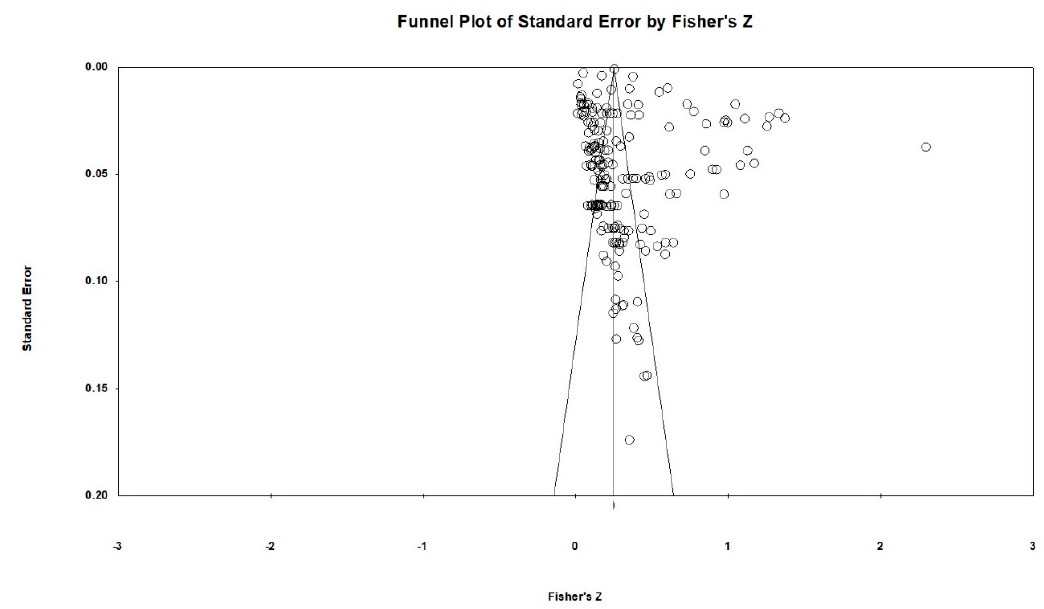
Figure 3. Funnel plot of publication bias.